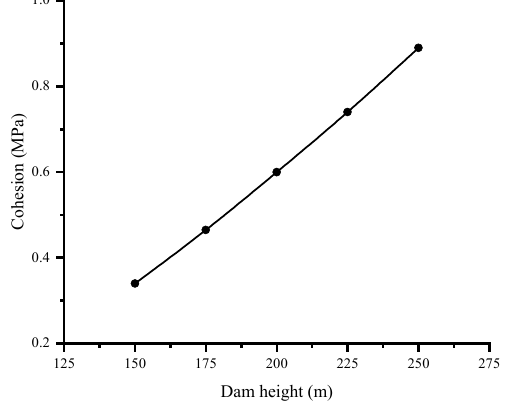
Figure 13. Relationship between cohesion of ACC that meets YSFCS and dam height .